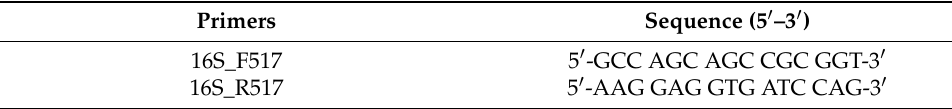
Table 1. Primers used for 16S rRNA gene